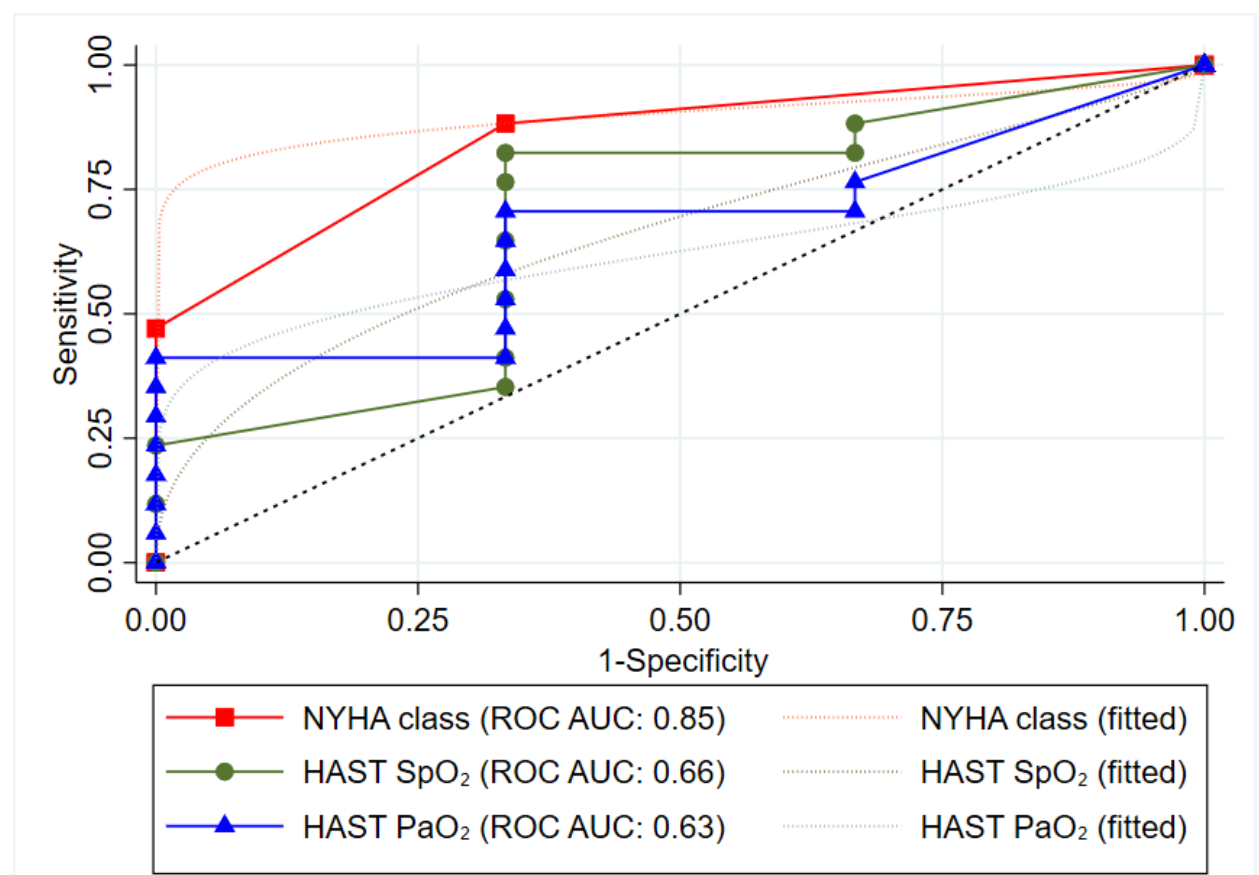
Figure 5. Receiver Operator Characteristic Curve for altitude related adverse health effects at 2500 m. HAST = High altitude simulation test including an exposure to normobaric hypoxia F i O 2 : 15%, NYHA = New York Heart Association class, ROC = Receiver Characteristic Operator Curve, AUC = Area under Curve.